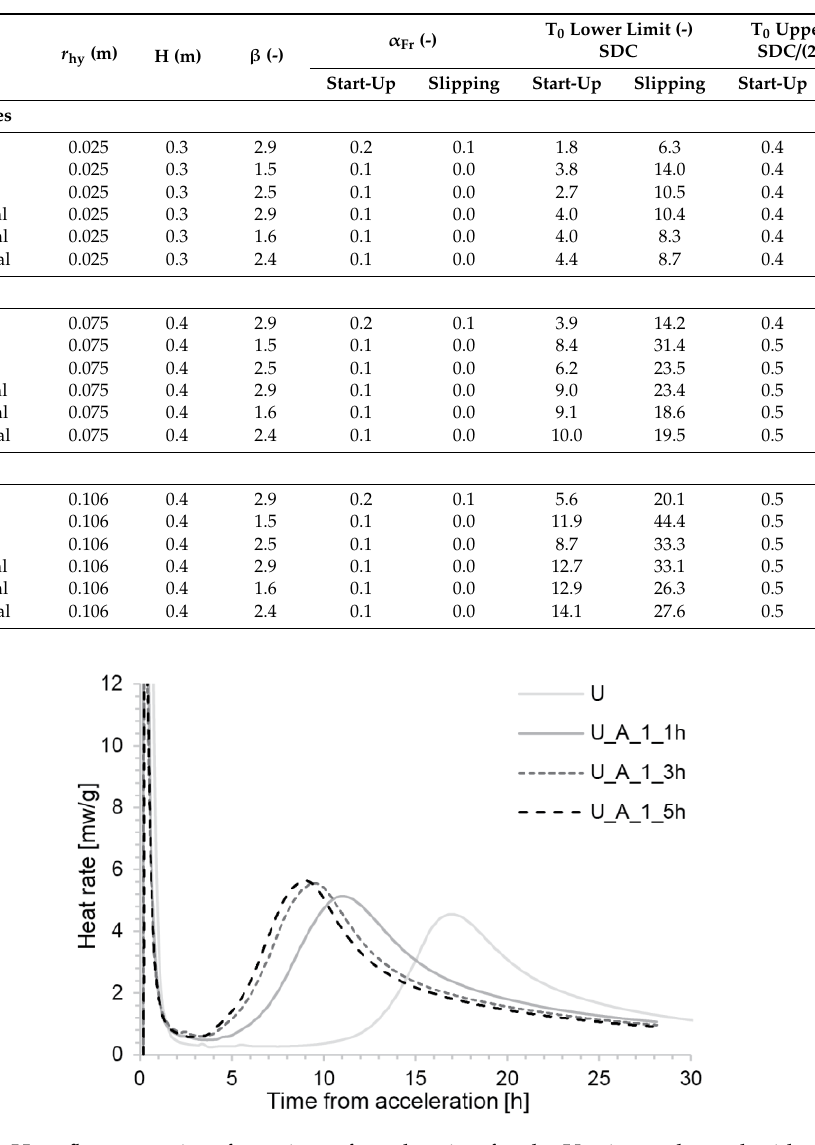
Table A3. Process window boundaries expressed in yield stress and dimensionless yield stress according to Equations (9) and (14) for thin folded structures.